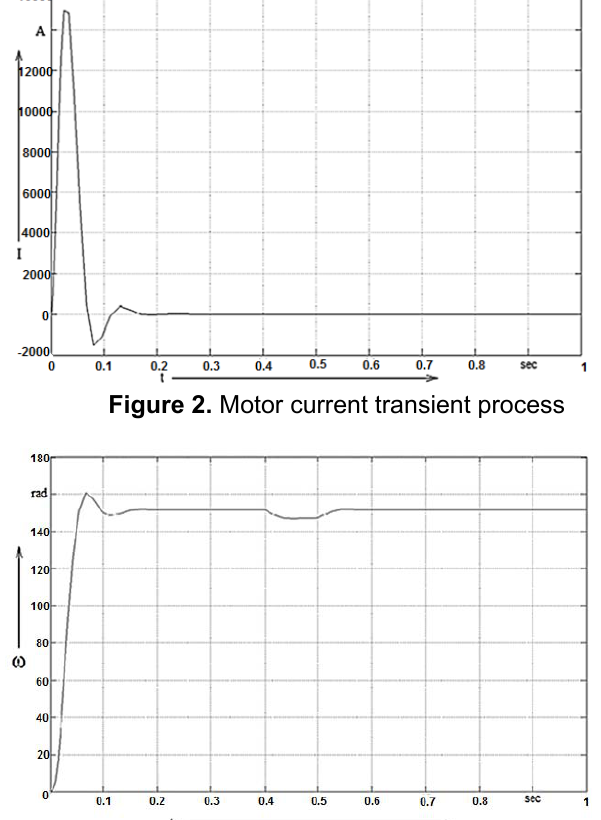
Figure 3. Motor speed transient process